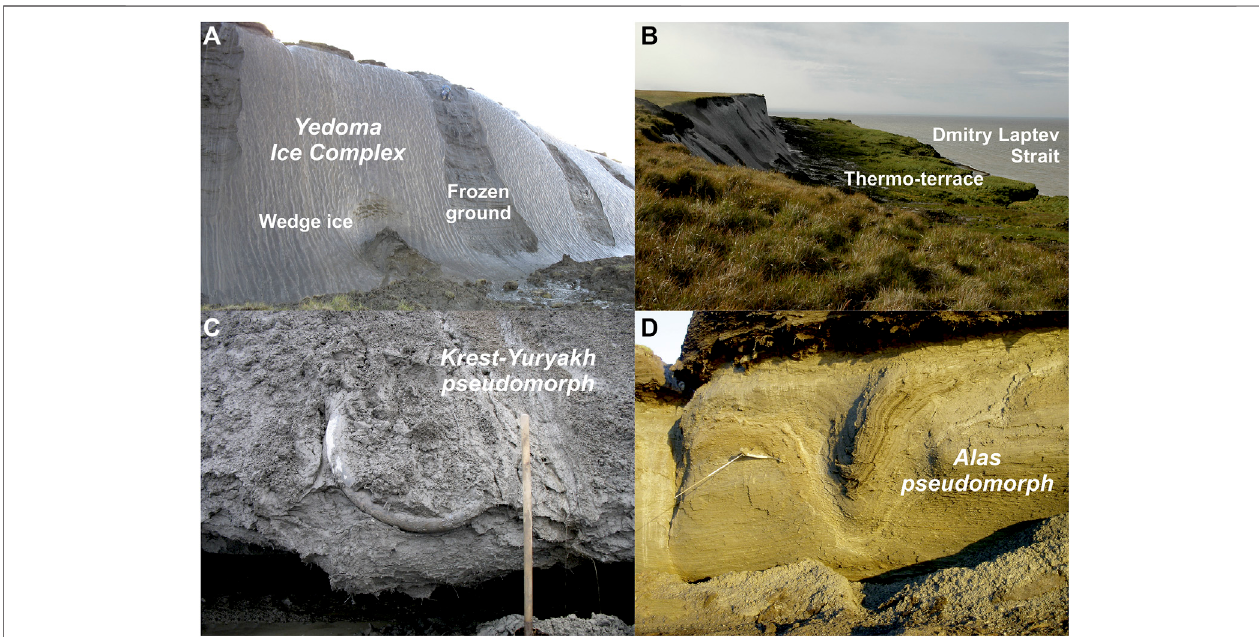
FIGURE 2 | Coastal exposures at the Kondrat ’ eva Yedoma (Dmitry Laptev Strait) showing (A) the Yedoma Ice Complex headwall (note climber dressed in blue at the top of the frozen ground deposit for scale), (B) the thermo-terrace below the headwall, (C) an ice wedge pseudomorph in Krest Yuryakh deposits, and (D) an ice wedge pseudomorph in lateglacial to Holocene alas deposits. Note in situ tusk fi ndings in (C) and (D) . Photographs in August 2007 by T. Opel, AWI (A) , F. Kienast, Senckenberg Weimar (B) , L. Schirrmeister, AWI (C) , and V.V. Kunitsky, MPI Yakutsk (D) .